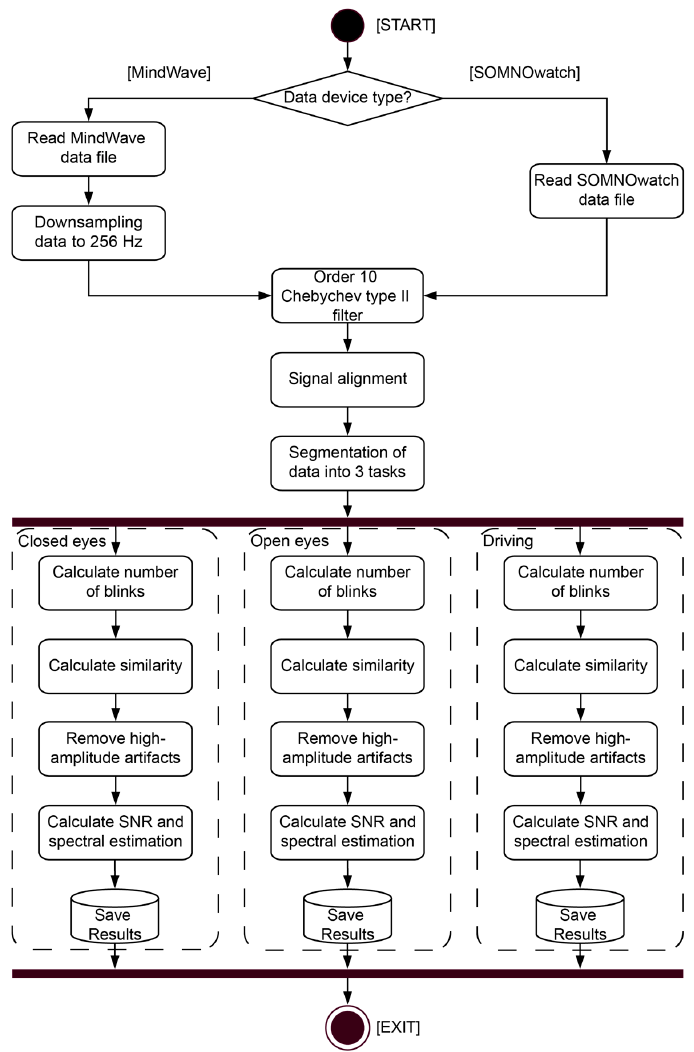
Figure 2. Data processing. UML (Unified Modeling Language) activity diagram for the experimental